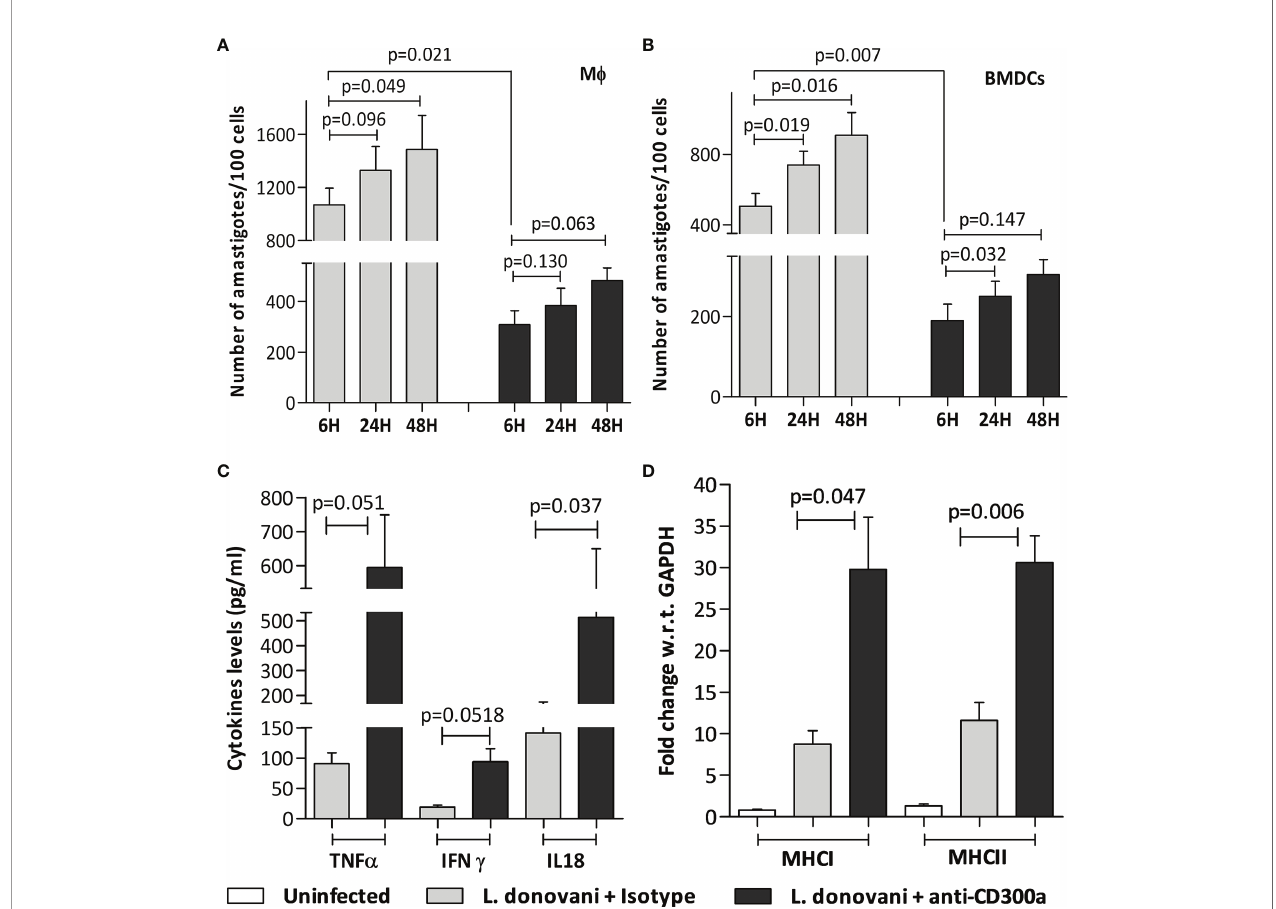
FIGURE 3 | Parasite load, cytokine levels, and MHC genes expression in anti-CD300a antibodies treated and untreated M j and BMDCs. (A, B): The prior incubation with anti-CD300a antibodies resulted in the reduced uptake of parasites in the SLA activated M j -like cell line RAW 264.7 (p=0.021; A ) and BMDCs (p=0.007, B ). The amastigote proliferation after 24h and 48h was found similar in cells in treated and untreated groups. The extracellular levels, measured after 72h by cytokine ELISA, of pro-in fl ammatory cytokines. TNF- a (p=0.051), IFN- g (p=0.051), and IL-18 (p=0.037) (C) along with MHC I and II genes expression levels (D) were elevated in SLA activated and parasites infected BMDCs after anti-CD300a antibodies